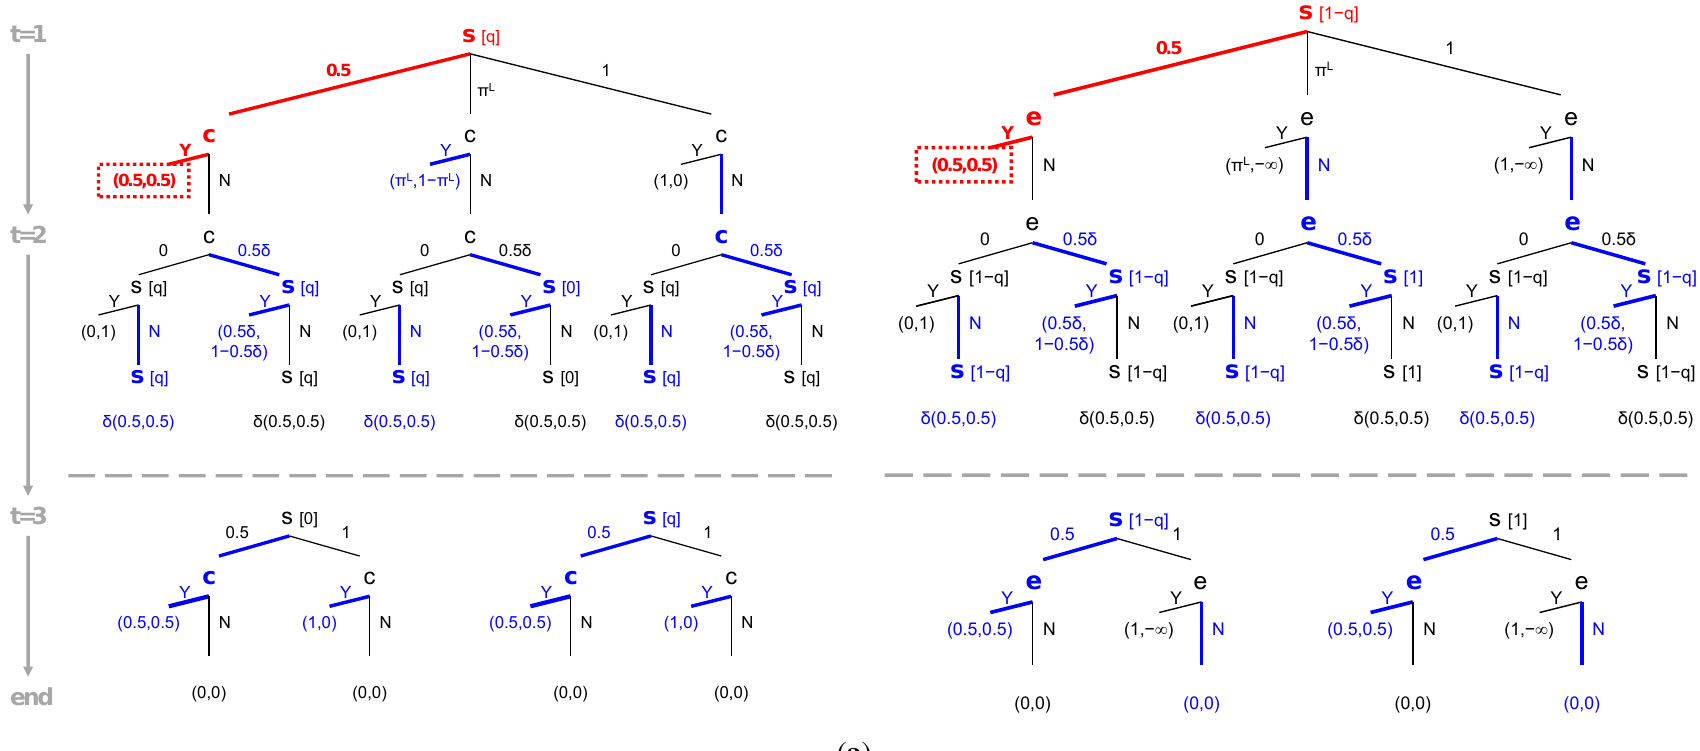
Figure 2. ( a ) Pooling equilibrium. ( b ) Pooling or separating equilibrium with one period of delay. ( c ) Pooling or separating equilibrium with two periods of delay.